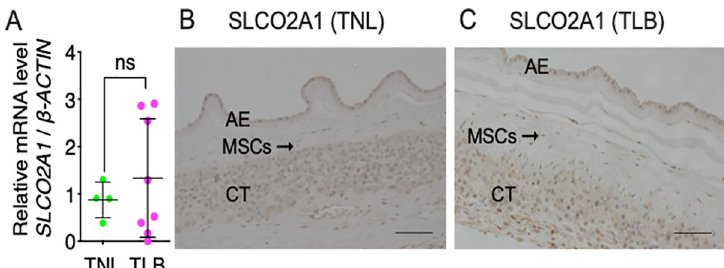
Fig 7. Expression of the prostaglandin transporter in fetal-membrane. (A) Relative levels of mRNA encoding SLCO2A1 in fetal-membrane of patients with term not in labor (TNL) or term in labor (TLB) deliveries were measured by RT-qPCR. Horizontal lines and error bars indicate the mean ± SEM. Data were analyzed by unpaired Student’s t - tests. ‘ns’, not significant. TNL, n = 4; TLB, n = 8. (B, C) Immunohistochemical staining of fetal-membrane from patients with (B) TNL and (C) TLB deliveries with an anti-SLCO2A1 antibody. Hematoxylin was used for nuclear counterstaining. Scale bars = 100 μ m. AE, amnion epithelium; MSCs, mesenchymal cells; CT, chorion trophoblast.